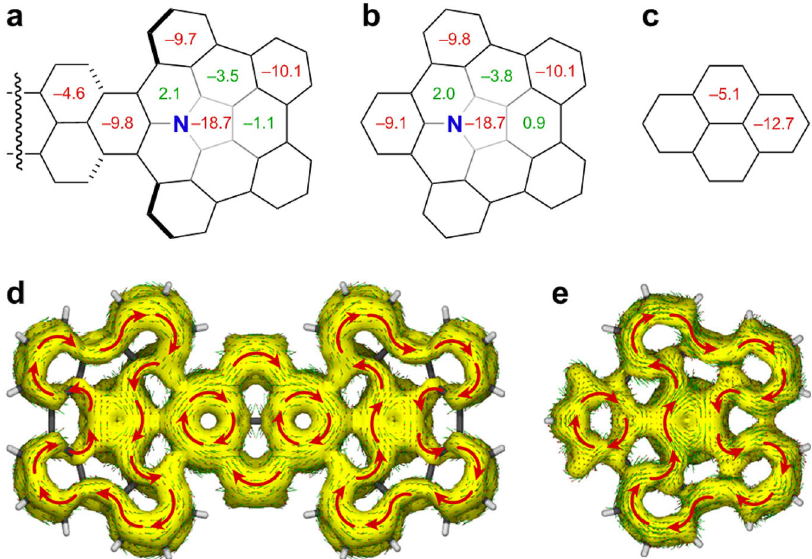
Fig. 6 Aromatic properties of azacorannulene dimer 4b. a NICS(0) values of 4b calculated at the B3LYP/6-31G(d) level of theory. b NICS(0) values of APBC. c NICS(0) values of pyrene. d ACID plot of 4b . e ACID plot of APBC. NATURE COMMUNICATIONS|